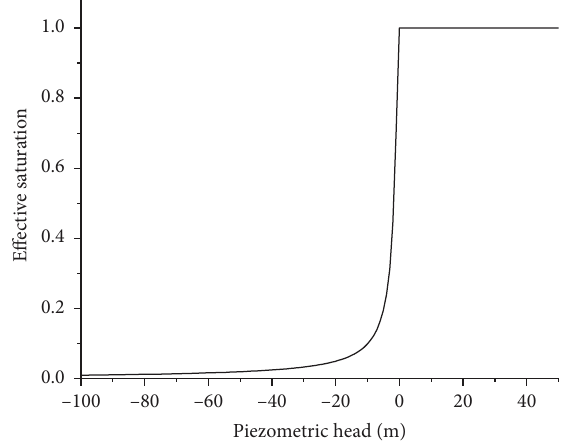
Figure 2: Soil moisture characteristic